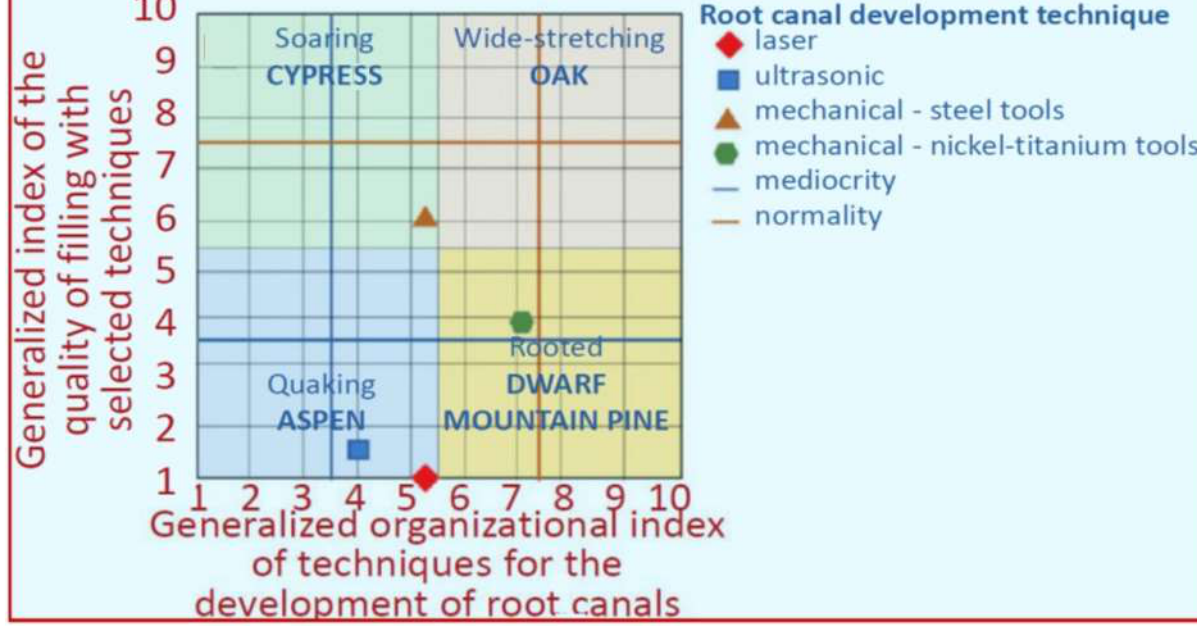
Figure 10. Contextual matrix of the attractiveness of root canal preparation techniques during endodontic treatment.